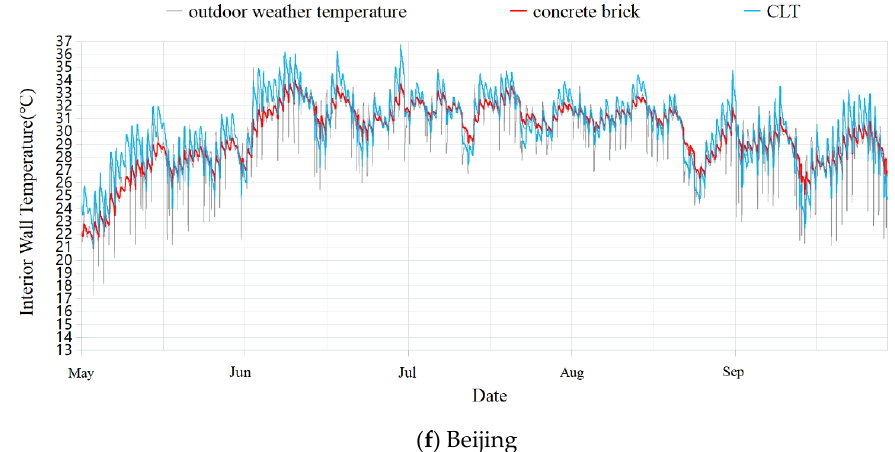
Figure 10. Comparison of concrete brick and CLT interior wall temperature in six cities from 1 May to 30 September.